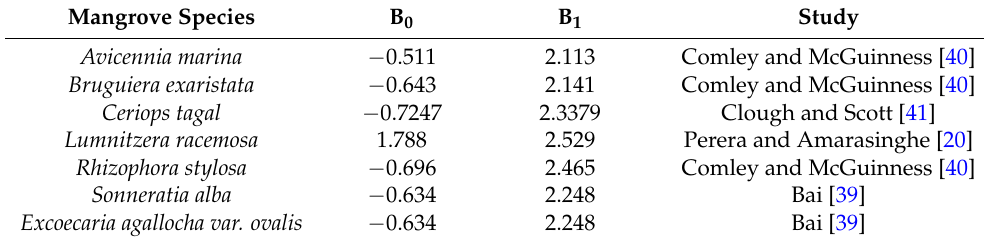
Table 3. Log 10 -transformed allometric relationships used for different mangrove species. The equations are in the form of log 10 ( Biomass ) = B 0 + B 1 ∗ log 10 ( DBH ) ; where DBH is the diameter at breast height; B 0 and B 1 are regression coefficients. These equations are specific to Northern Australia